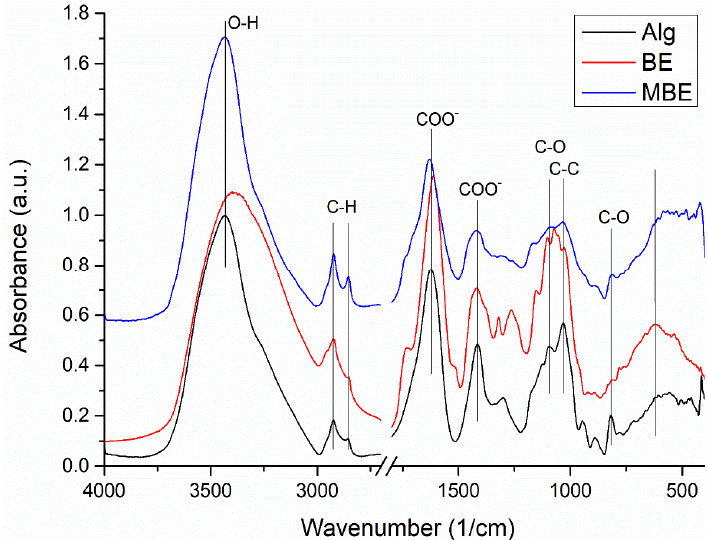
Figure 2. The FTIR spectra of sodium alginate (Alg), basil extract (BE) and microencapsulated basil extract (MBE), 4000–400 cm −1 spectral domain, 2700–1800 cm −1